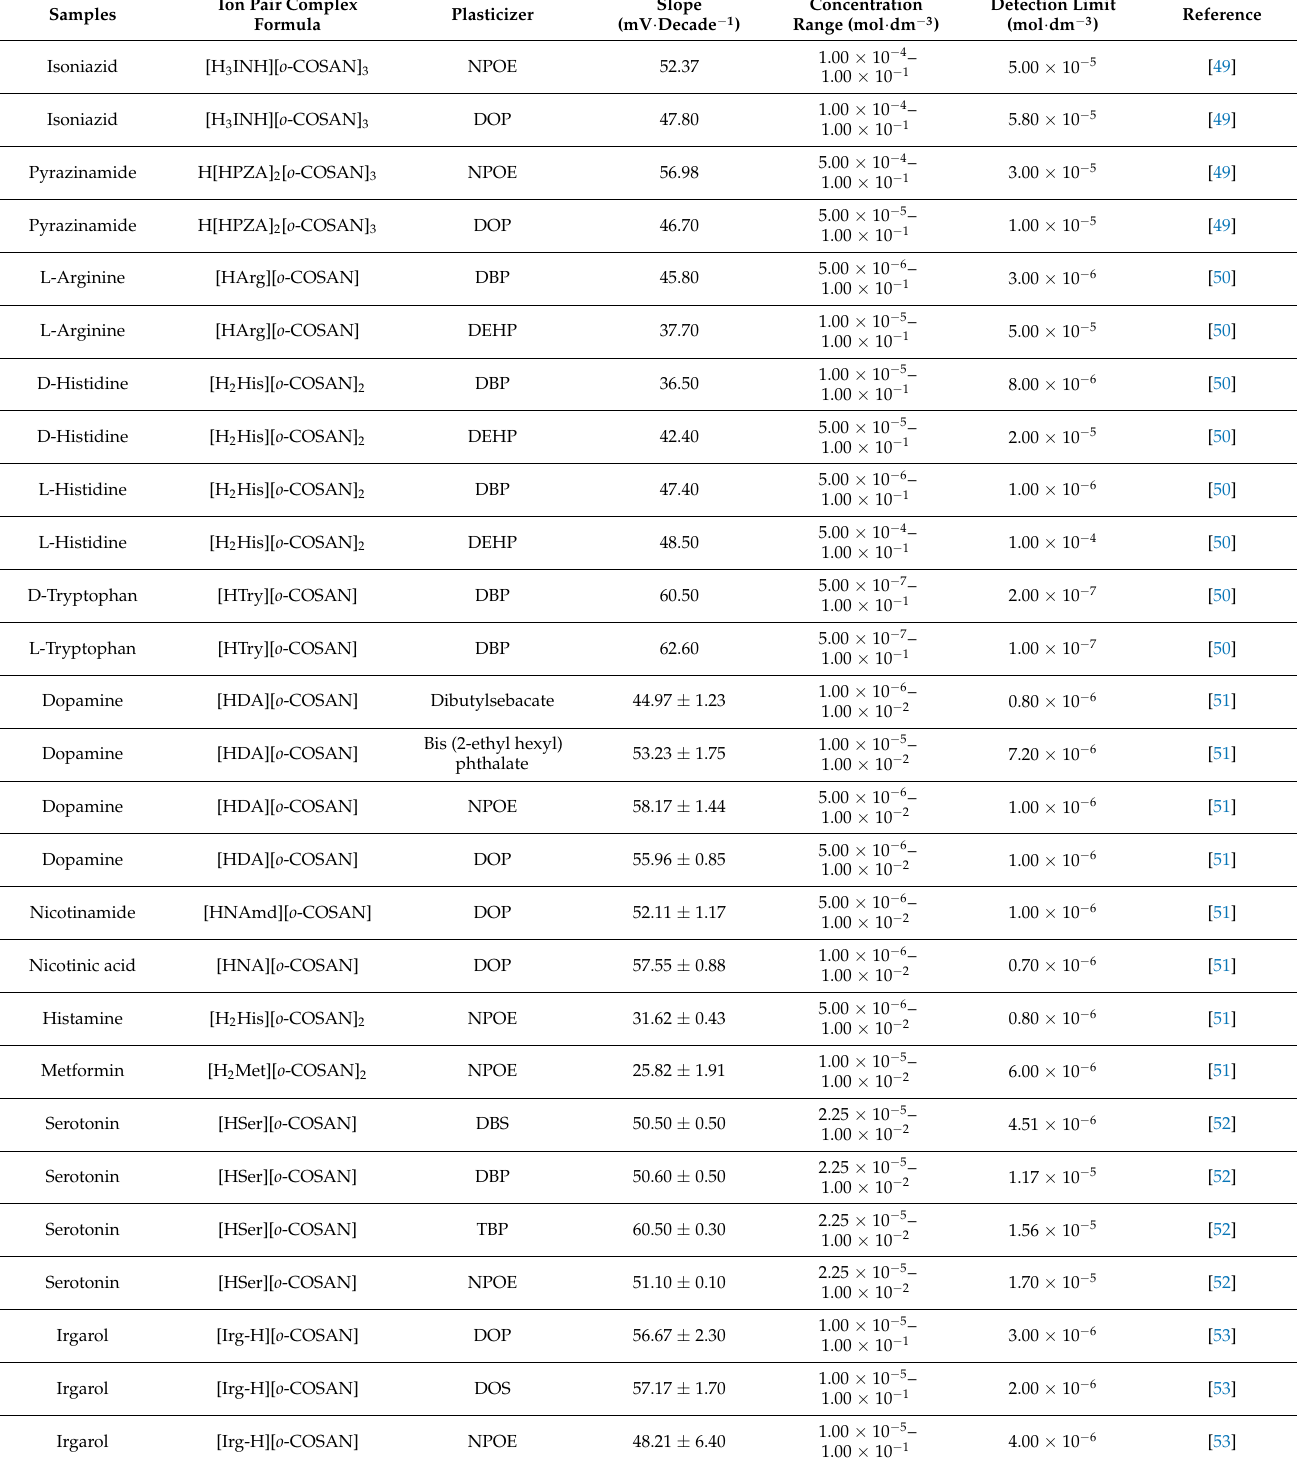
Table 1. Analytical performances of ISEs prepared for [cation-NH] x [3,3 (cid:48) -Co(1,2-C 2 B 9 H 11 ) 2 ] y . The plasticizer is abbreviated as: o -nitro phenyl octyl ether (NPOE); di-octyl phthalate (DOP); di-butyl phthalate (DBP); di-octyl sebacate (DOS), bis(2-ethylhexyl) phthalate (DEHP); tributyl phosphate